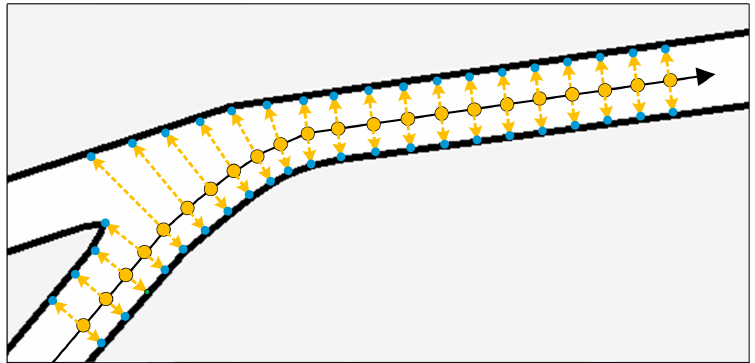
Figure 6. The illustration of the extraction of the innermost road boundary point by probe-based sampling, where the yellow nodes represent the trajectory of the vehicle and the blue nodes represent the sampled road boundary.